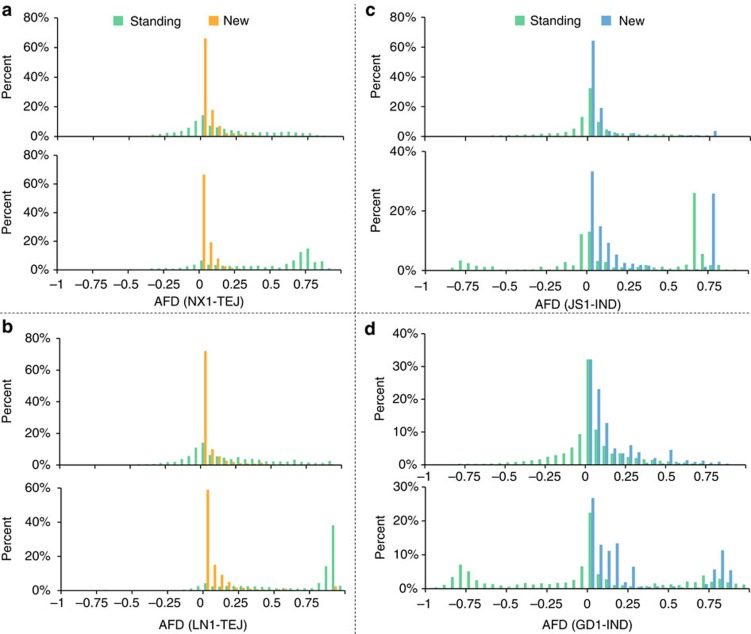
Percentage distribution of alternative allele frequency differentiation for standing and new variations between weedy and cultivated rice.The AFD was measured by subtracting the alternative allele frequency of cultivated rice group from the corresponding weedy rice. (a) NX1-TEJ; (b) LN1–TEJ; (c) JS1–IND; (d) GD1–IND. The distributions for genome wide SNPs were shown on the top of each subfigure, and SNPs in the identified selected regions (Fig. 4b) are shown at the bottom. Percentages of standing variations are plotted in green histograms, and new mutations of japonica and indica type are depicted in orange and blue histograms, respectively.